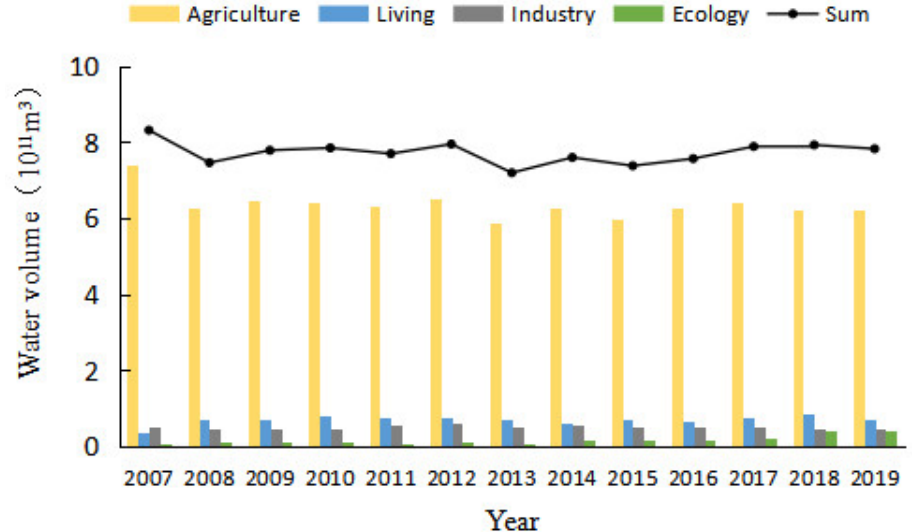
Figure 10. Water use structure and trend for Erhai Lake from 2007 to 2019. There was no significant negative correlation between water consumption and total water consumption from 2007 to 2019, and the correlation coefficient was − 0.22. The correlation coefficient between water volume and agricultural water consumption was 0.163, the correlation coefficient between water volume and living water consumption was − 0.324, the correlation coefficient between water volume and industrial water consumption was − 0.126, and the correlation coefficient between water volume and eco-environmental supplemental water consumption was − 0.658 ( p < 0.05). The change in Erhai Lake water was less affected by the total water consumption of the basin (Table